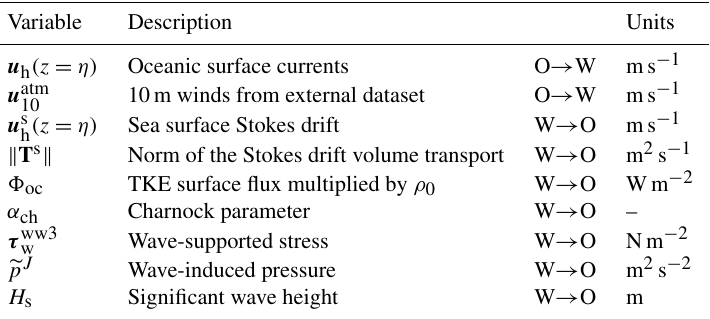
Table 1. Variables exchanged between NEMO (O) and WW3 (W) via the OASIS-MCT coupler. The 10m wind u atm by WW3 and does not go through the OASIS-MCT coupler.